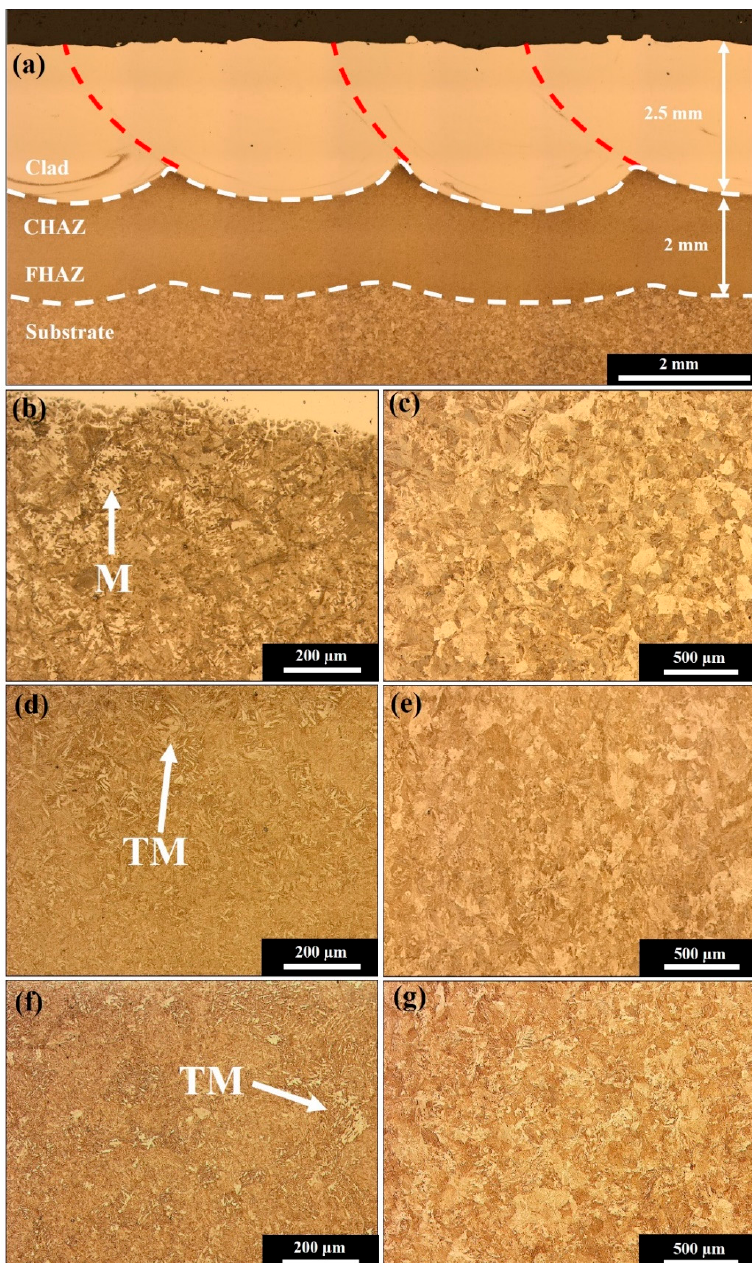
Figure 3. Transverse microstructure showing the ( a ) cladding, coarse (CHAZ), and fine (FHAZ) regions within the HAZ and the rail substrate. The untampered rail contains ( b ) untempered martensite (M) in the CHAZ before reaching the ( c ) pearlitic substrate. The 350 ◦ C heat treatment produces ( d ) tempered martensite (TM) in the HAZ and ( e ) pearlitic substrate. A 540 ◦ C tempering causes a refinement of the ( f ) HAZ without significantly changing the ( g ) pearlitic substrate rail. The untempered rail contains a light phase of martensite in the upper region of the HAZ which coexists with pearlitic microstructure, as indicated in Figure 3b.